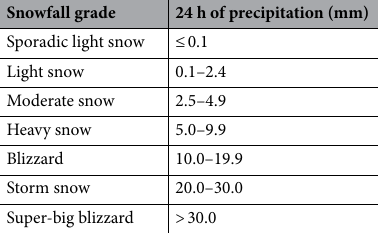
Table 5. Snowfall grade classification.